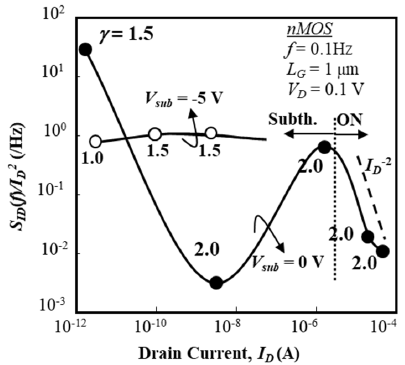
Figure 5. Normalized fluctuation power spectral intensity ( S I D f I ) of drain current as a function of I D in 1- μ m gate IC nMOS. L G =1 μ m and W G = 50 μ m. Substrate voltage ( V sub ) is 0 V and –5 reveals a deep depression around I D ~10 − 8 A for V sub = 0 V. This